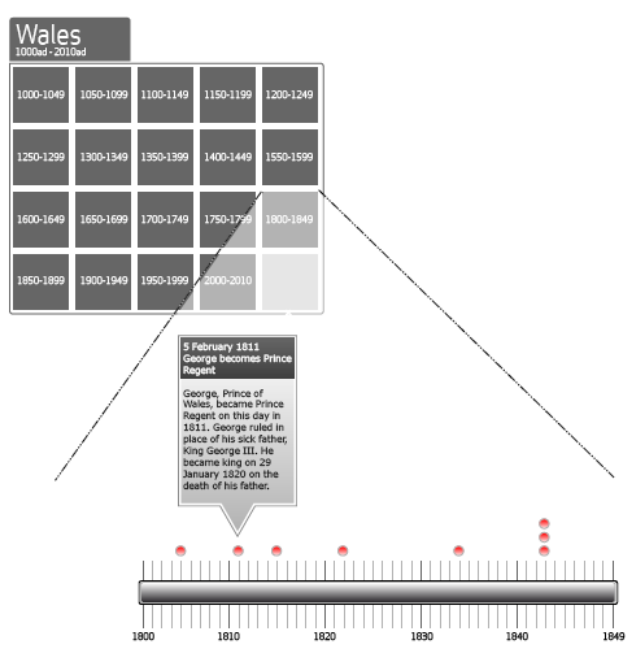
Figure 15 . An example of the Welsh history timeline Compendium